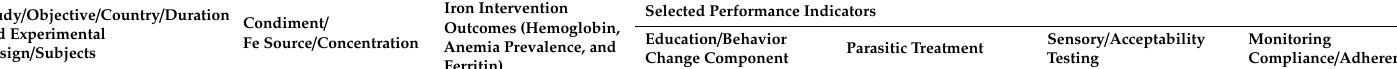
Table 1. Data extraction for systematically selected 23